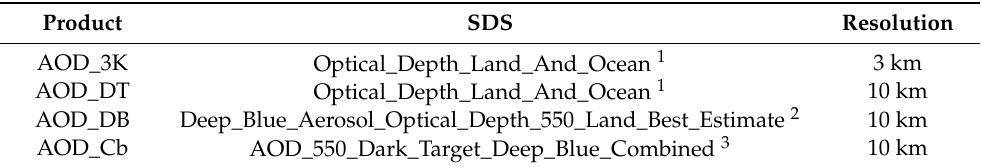
Table 1. Aerosol optical depth (AOD)-scientific datasets (SDSs) from the moderate-resolution imaging spectroradiometer (MODIS) aerosol